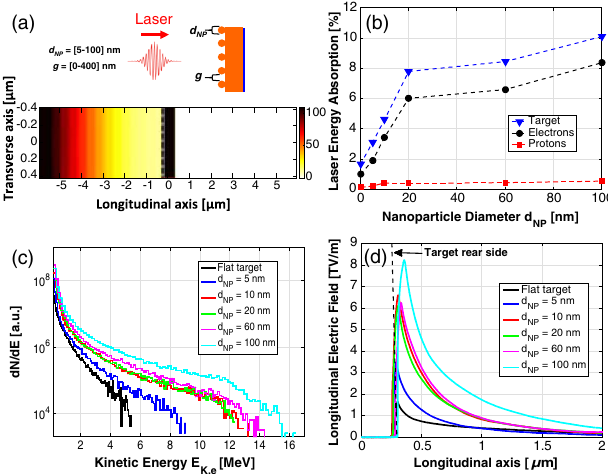
FIG. 3. (a) Schematic geometry of the PIC simulations. (b) Laser energy absorption for different nanoparticle diameters, comparing energy absorption from the whole target (blue triangles), from laser electrons (black circles) and from protons (red squares). (c) Hot electron spectra for different nanoparticle diameters. (d) Mean longitudinal electric field at a central radial position.